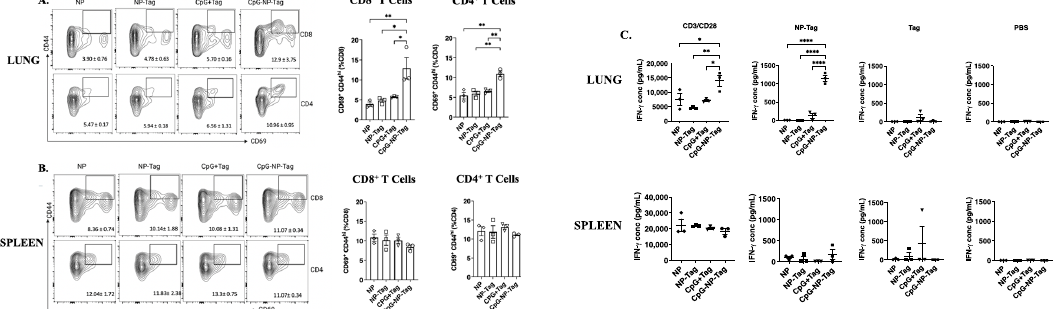
Figure 6. Intranasal CpG-NP-Tag drives tumor antigen-induced T cell activation in lungs of BALB/C mice. ( A , B ) Representative FACS blots of CD69 and CD44 expression and proportions of CD69 + CD44 hi cells within CD8 + and CD4 + in the lungs ( A ) and spleen ( B ) of experimental mice 21 days post immunization after ex vivo restimulation with viable 4T1 tumor cells. ( C ) Concentrations of IFN- γ in culture supernatants of lung leukocytes (upper panels) and spleenocytes (lower panels) from experimental mice 21 days post immunization after ex vivo stimulation with NP-Tag and Tag for 4 days using CD3/CD28 and PBS as positive and negative controls, respectively. One-way ANOVA followed by Tukey’s multiple comparison test. **** p < 0.0001, ** p < 0.01, * p <